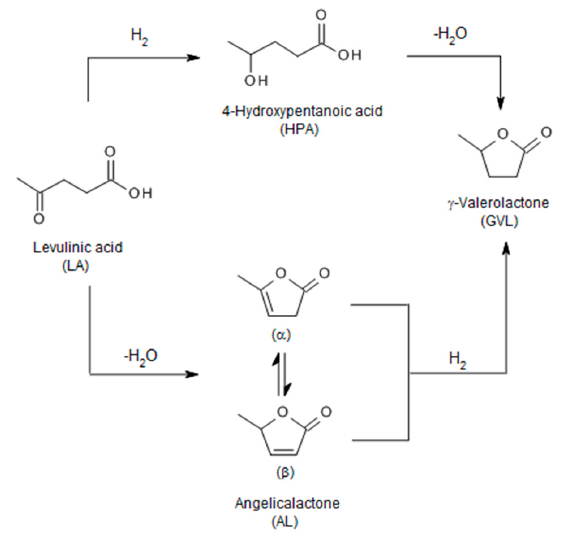
Figure 6. Overall reaction pathway to produce γ -valerolactone (GVL).